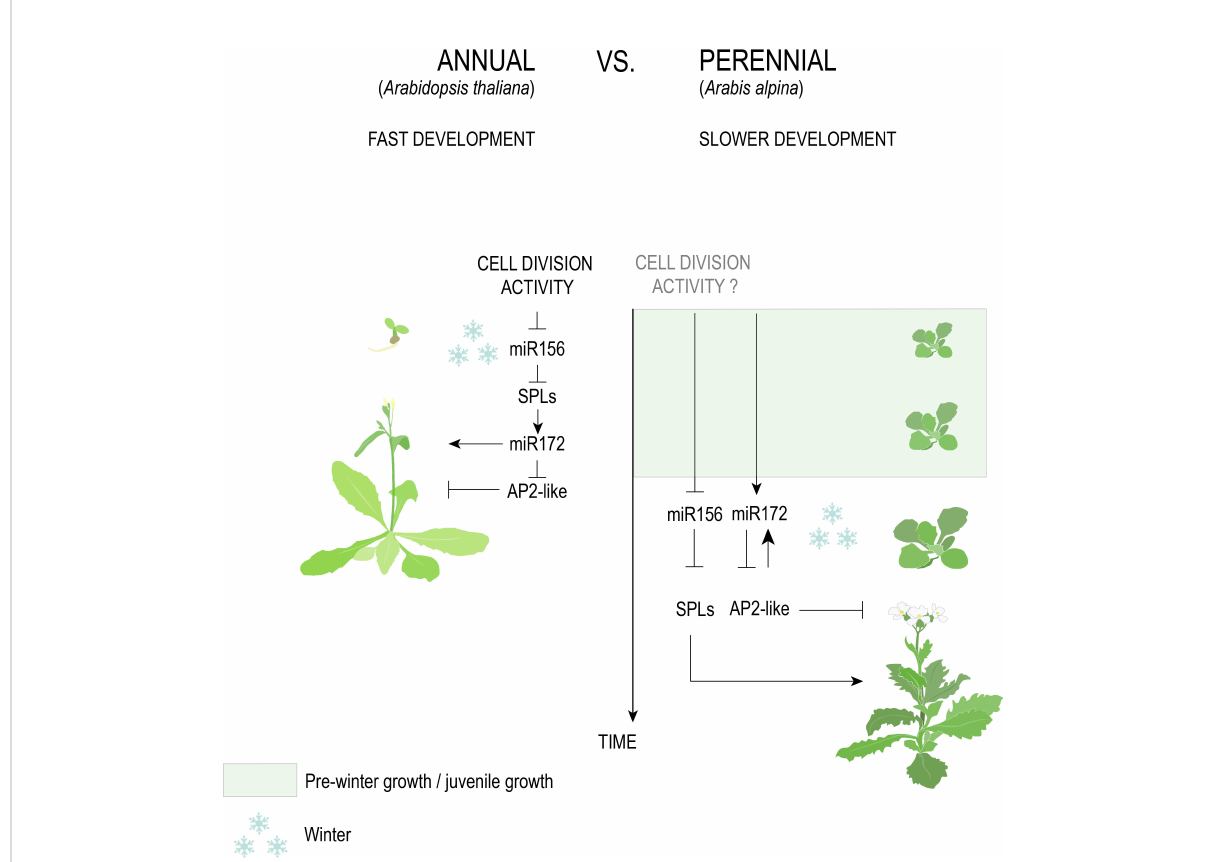
FIGURE 5 The genetic pathway of age in Brassicaceae. The antagonistic age-dependent relationship between miR156 and miR172 negatively regulates fl oral activators (SPLs) and fl oral repressors (AP2-like), respectively. A fast decline of miR156, triggered by cell division activity, in A. thaliana versus A. alpina , explains the former ’ s response to vernalization at a very early age and why the latter requires an extended period of growth before cold